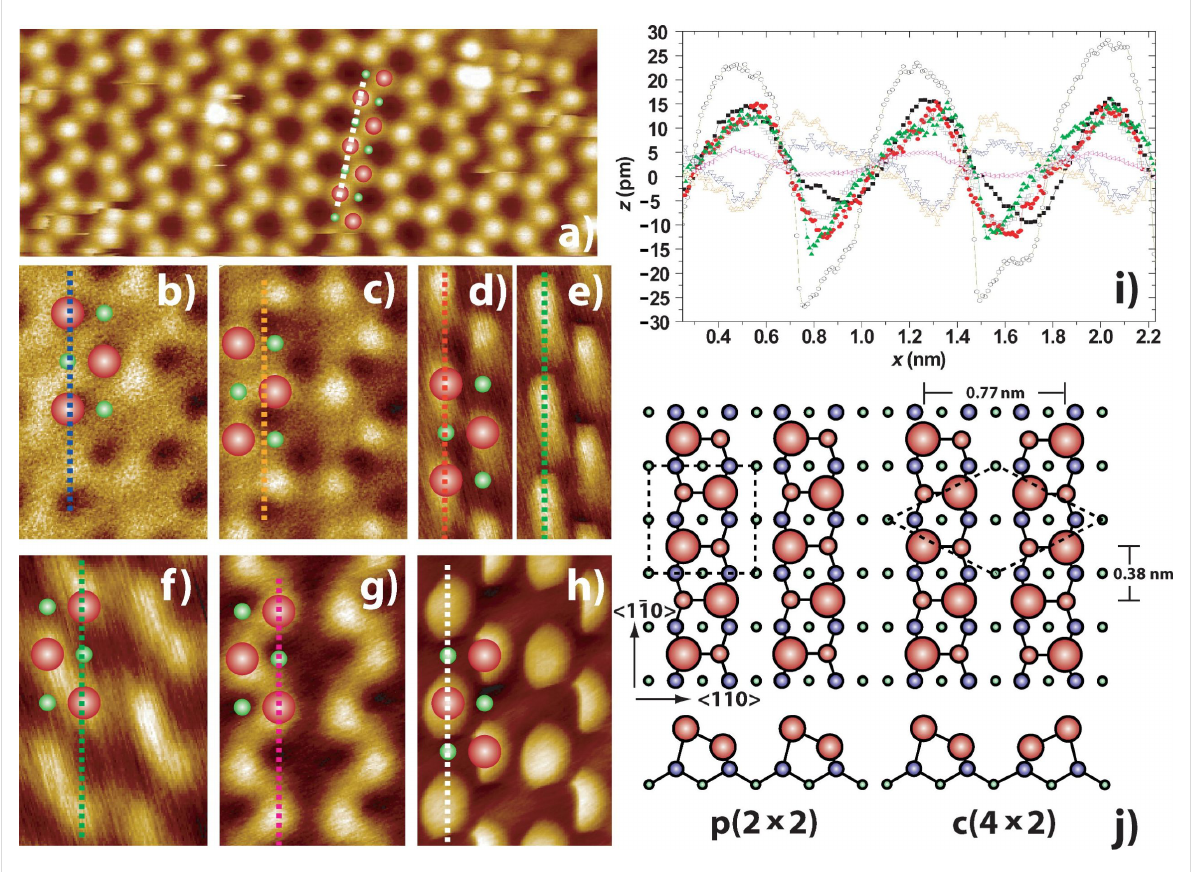
Figure 1: Topographs acquired in constant Δ f NC-AFM of Si(100) at 5 K, demonstrating different imaging mechanisms. Images have been rotated to align the direction of dimer rows. (a) High quality “conventional” image, “slicing” of some atoms indicates scan-induced dimer manipulation [19] Image size 8.9 nm × 3.5 nm. Δ f set = − 46 Hz, A 0 = 0.25 nm. (b) “Inverted” image. Δ f set = − 53 Hz, A 0 = 0.1 nm. (c) Subsequent scan of the same region as (b) with the same tip apex at higher Δ f setpoint showing a “depression/protrusion” double image. Δ f set = − 54 Hz, A 0 = 0.1nm. (d) and (e) “Dimer”-type image showing the difference between the forward (d) and reverse (e) scan directions. Δ f set = − 10 Hz, A 0 = 0.25 nm. (f) “Crescent”-type image. Δ f set = − 40.5 Hz, A 0 = 0.25 nm. (g) “Wormlike” image. Δ f set = − 10.4 Hz, A 0 = 0.25 nm. (h) “Discuslike” image. Δ f set = − 44 Hz, A 0 = 0.25 nm. In each image the dotted line shows the location of the line profiles and the illustration shows the apparent position of the atoms in the c(4 × 2) reconstruction (large red - “up” atoms, small green - “down” atoms). Image size (b), (c) and (f)–(h) 1.4 nm × 2.1 nm, (d) and (e) 0.8 nm × 2.1 nm. (i) Line profiles from posi- tions indicated in (a)–(h). (a) “Conventional” (black filled squares), (b) “Inverted” (empty blue triangles), (c) “Inverted high setpoint” (empty orange triangles), (d) “Dimer” forward (filled red circles), (e) “Dimer” back (filled green triangles), (f) “Crescent” (empty green squares), (g) “Wormlike” (empty pink triangles), (h) “Discuslike” (empty black circles), (j) Ball and stick model of the Si(100) surface reconstruction showing in-phase (p(2 × 2)) and out- of-phase (c(4 × 2)) dimer